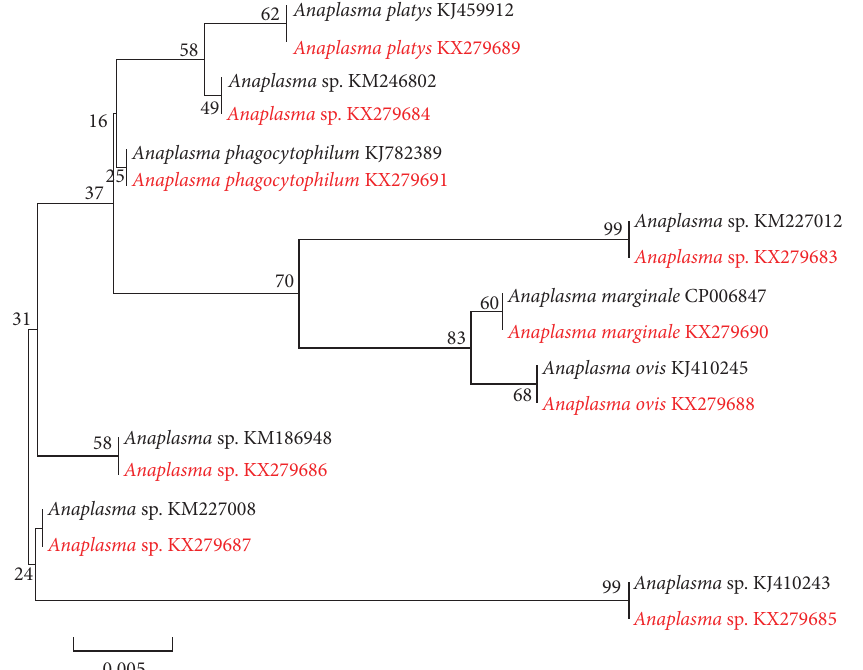
Figure 3: Phylogenetic comparison of Anaplasma spp. from ruminants in this study. The 16S rRNA sequences (in red font and accession number)arecompared withthoseofotherrepresenting Anaplasma spp. (inblack fontandaccession number). Branchlengthsaremeasuredin nucleotide substitutions and numbers show branching percentages in bootstrap replicate. Scale bar represents the percent sequence diversity.